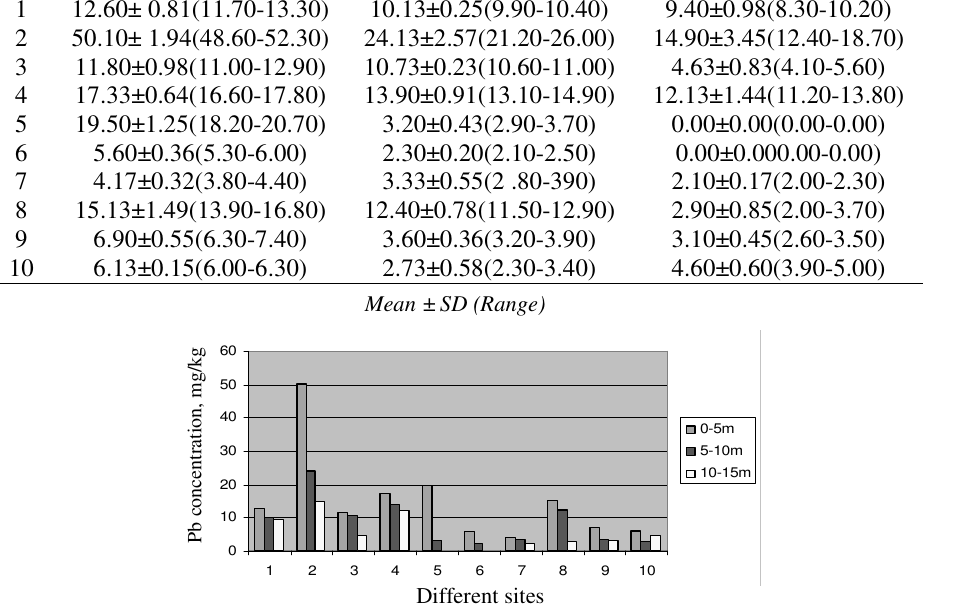
Table 2. Lead (mg/kg) in roadside agricultural soil at selected sites Distance from road (m) Site